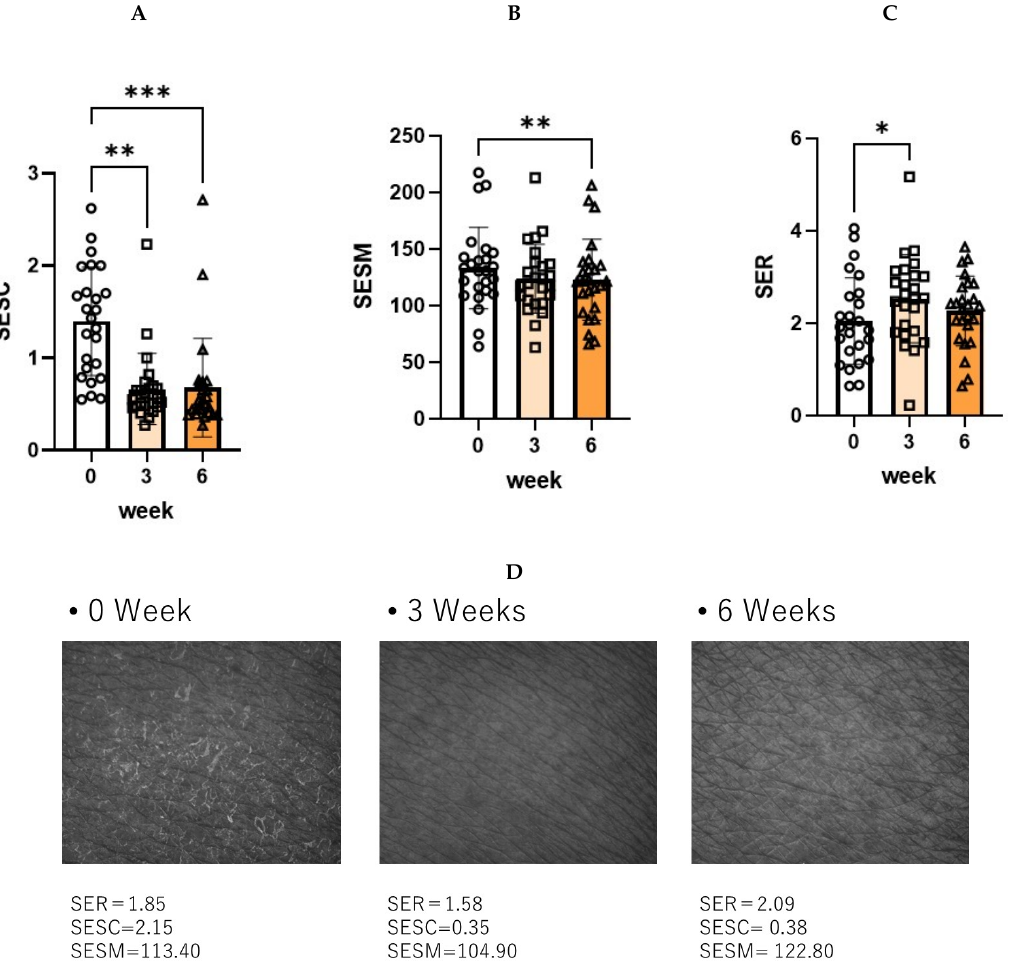
Figure 8. Skin Surface Evaluation by Visioscan. ( A ): Scaliness (SESC) n = 25, ( B ): Smoothness (SESM), n = 25 ( C ): Roughness (SER) n = 25, ***: p < 0.001, **: p < 0.01, *: p < 0.05 compared to week 0, all data were analyzed by Tukey’s multiple comparison test and are expressed as means ± SD. ( D ): Representative photos at 0, 3, and 6 weeks.